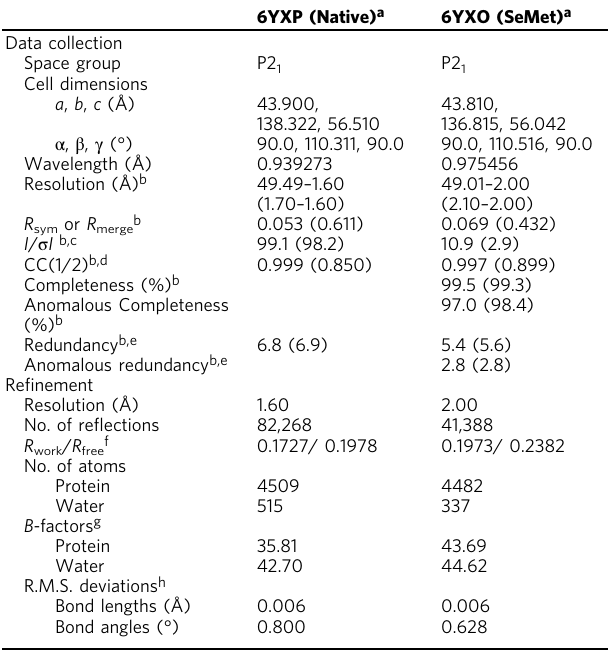
Table 1 Data collection, phasing and re fi nement statistics for SAD (SeMet) structure